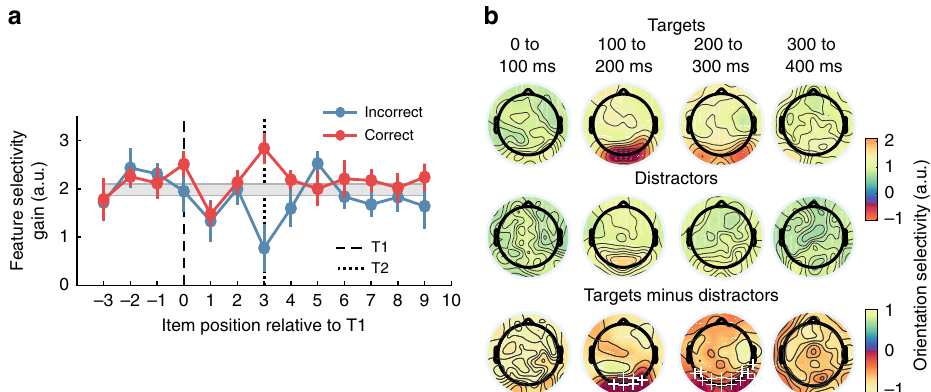
Fig. 8 Feature selectivity and scalp topographies for targets and distractors in Experiment 2. a Neural feature selectivity (gain of Gaussian) of target and distractor representations for Lag 3. Blue lines show incorrect trials and red lines show correct trials. Gaussians were fi t to the averaged neural representation from 100 to 150 ms. To aid comparison, the grey bar indicates the average distractor representation ( ∓ 1 standard error of mean). Note that all distractors and targets have gain values signi fi cantly above 0 arbitrary units (a.u.) indicating robust feature selectivity. Error bars indicate ∓ 1 standard error of mean. b Headmaps showing univariate orientation selectivity over time, plotted separately for targets and distractors. Plus symbols indicate positive cluster-permuted differences between targets and distractors (two-tailed cluster-permutation, alpha p < 0.05, cluster alpha p < 0.025, N permutations =